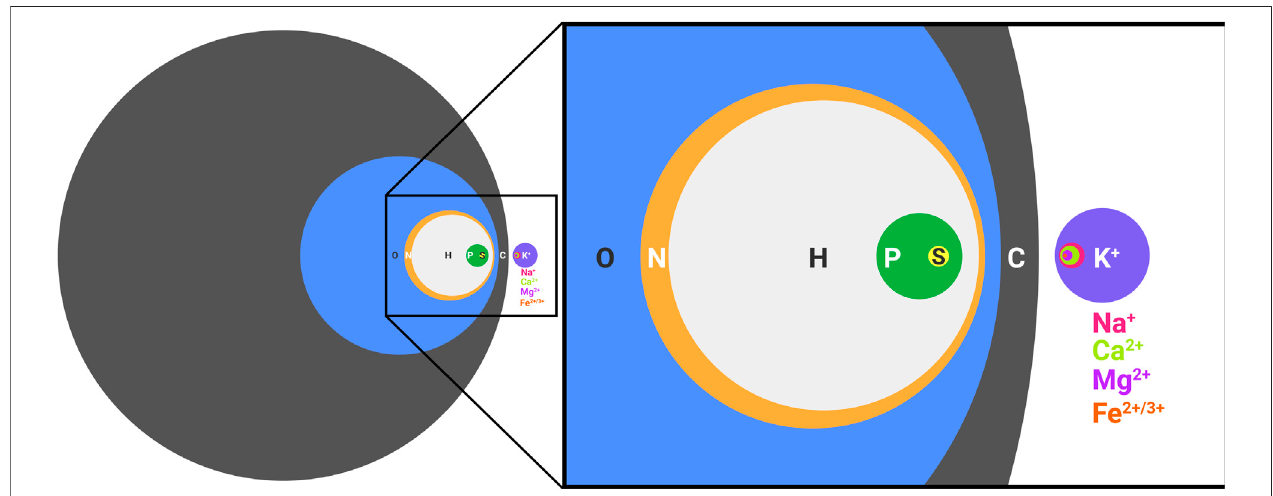
FIGURE 1 | CHNOPS and the most abundant metal ions of a biological cell. Diameters are proportional to percent dry weight. Data are of an average bacterial composition and taken from Lawford and Rousseau, 1996; Tchobanoglous Burton, Franklin L., Stensel, H. David, Metcalf and Eddy, 2003.